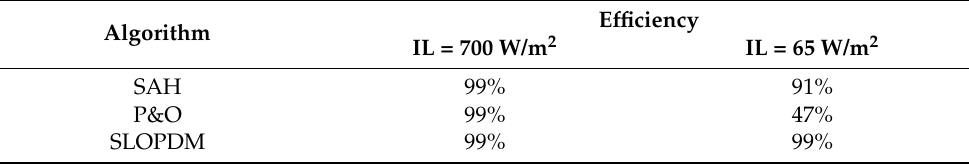
Table 6. The comparison of proposed SLOPDM, SAH, and P&O algorithms under